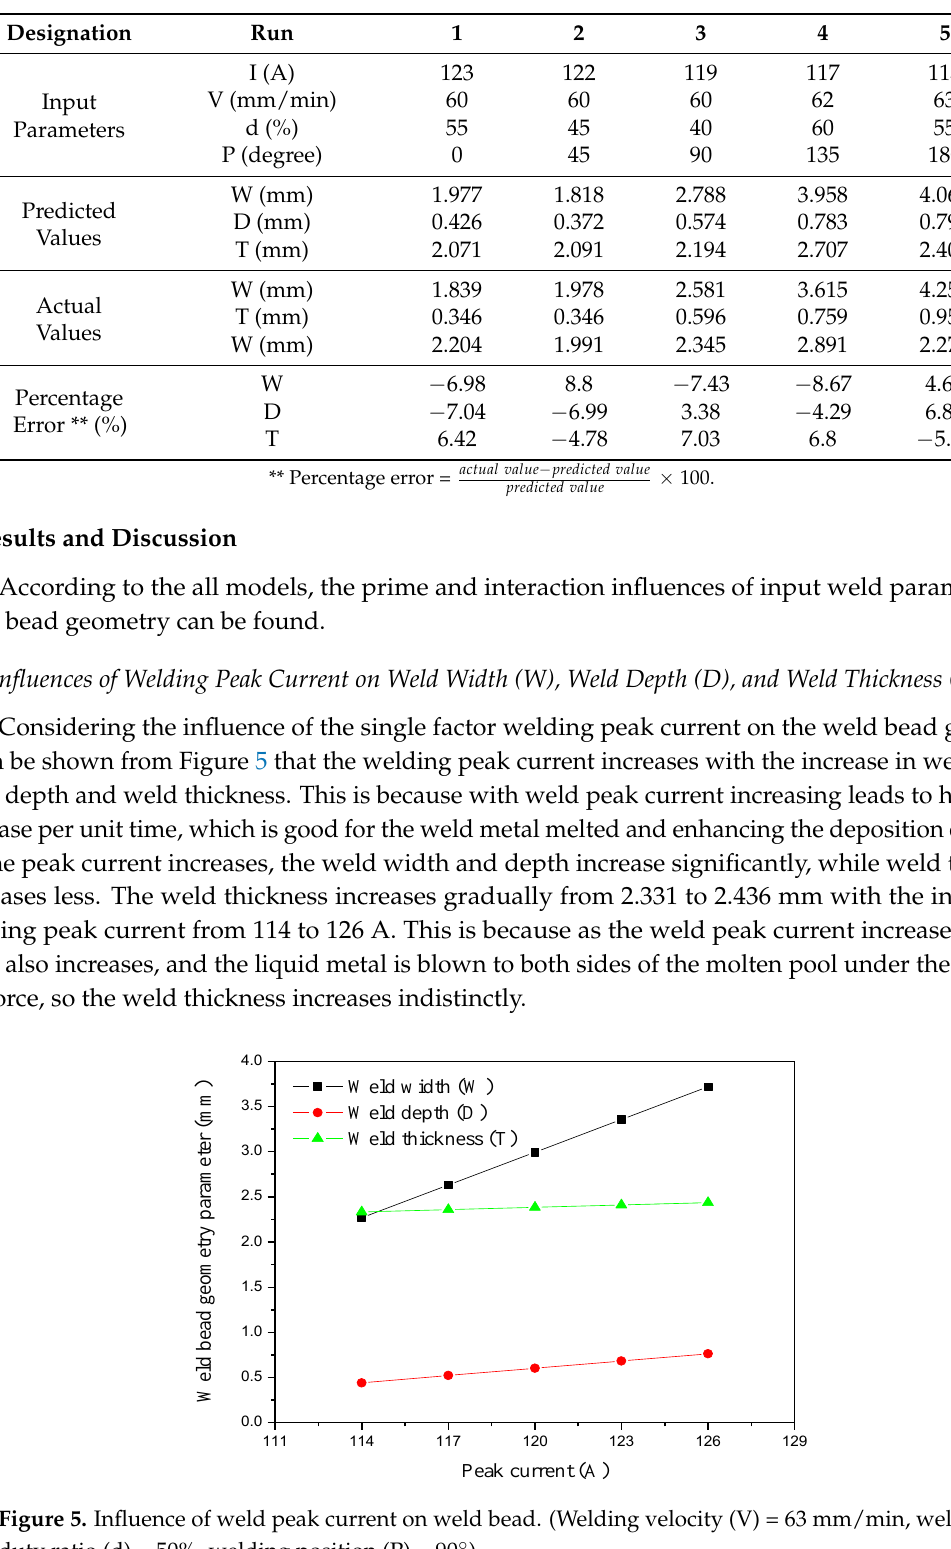
Table 7. Predicted values and actual values of the weld bead geometry.